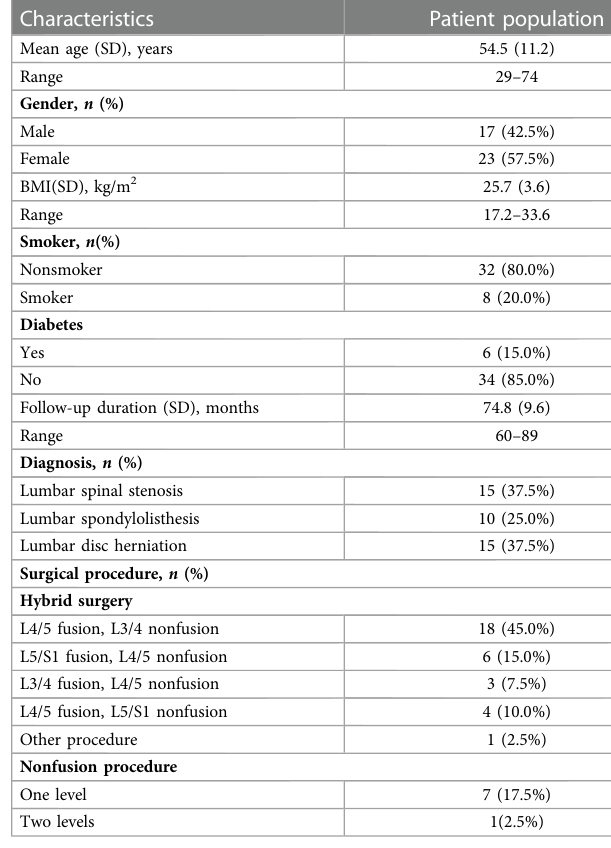
TABLE 1 Baseline characteristics of patient.